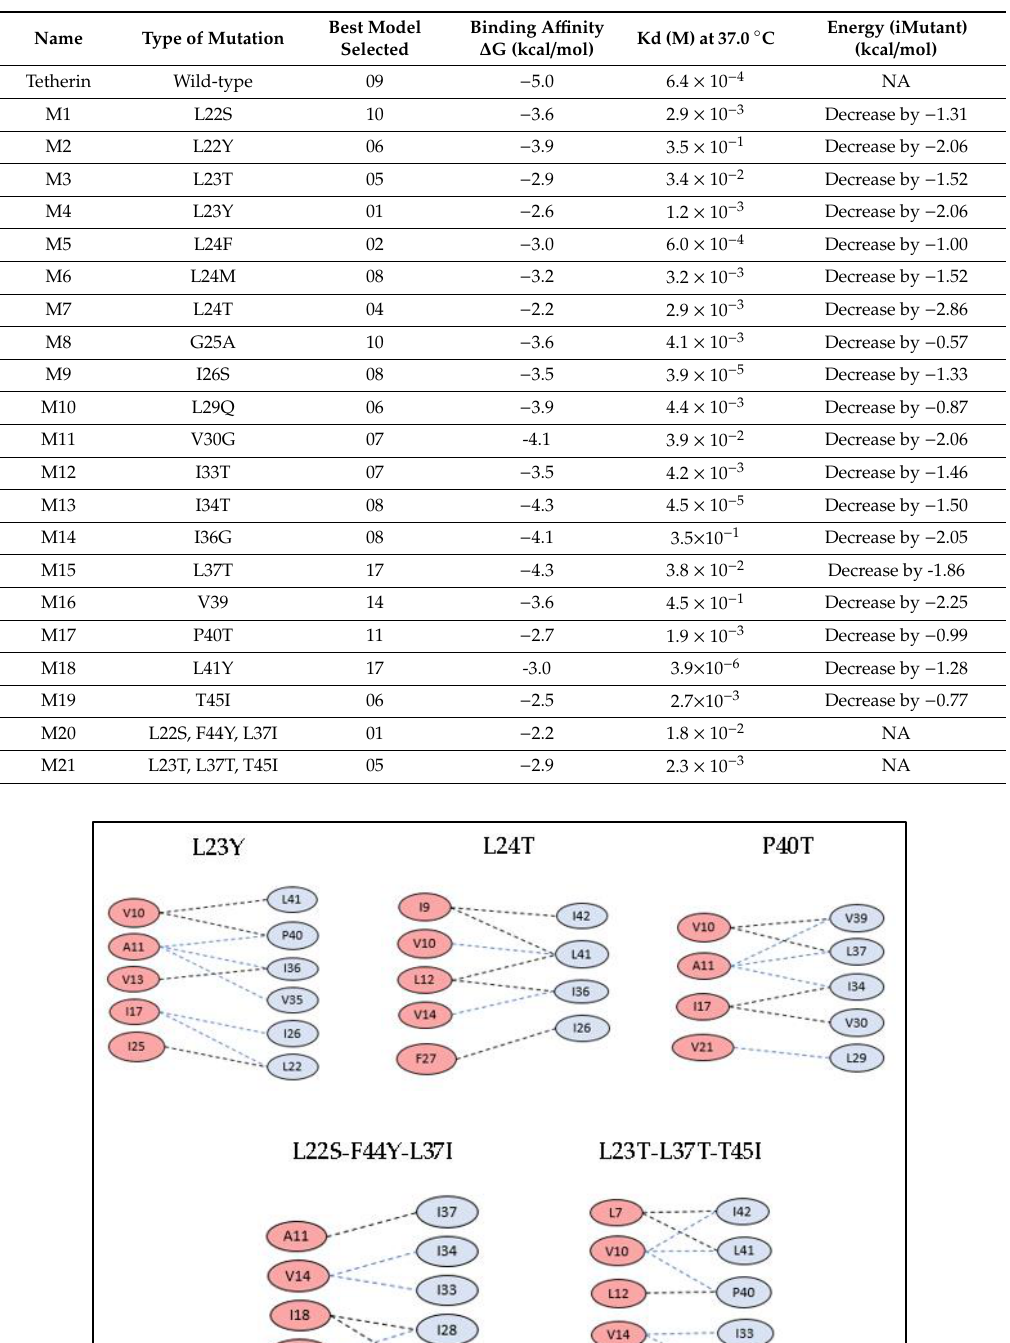
Table 5. This table represents the positions of mutations performed in tetherin, the best tetherin-Vpu interaction model (docked model) in Hex, binding a ffi nity of the respective docked complexes, and their Kd values.